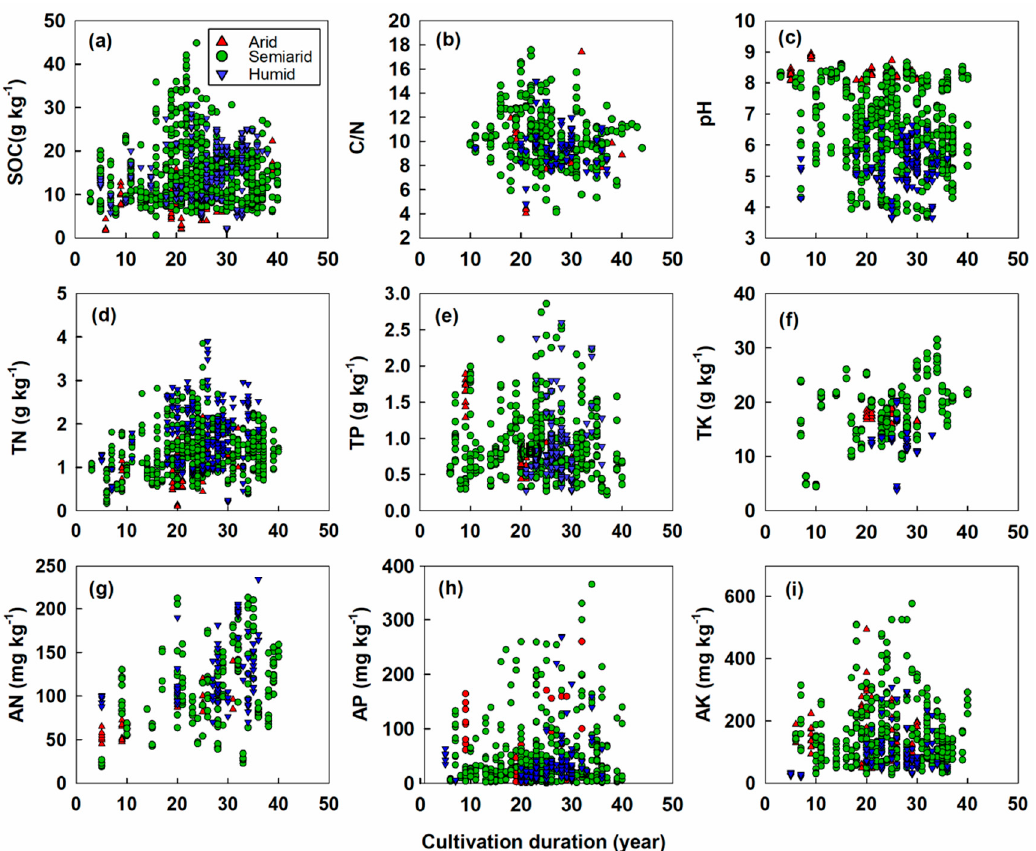
Figure 11. Effect of fertilizer on soil chemical properties. SOC ( a ): soil organic carbon, C/N ( b ): organic carbon − nitrogen ratio, pH ( c ), TN ( d ): total nitrogen, TP ( e ): total phosphorus, TK ( f ): total potassium, AN ( g ): alkali − hydrolysable nitrogen, AP ( h ): available phosphorus, AK ( i ): available potassium) with different HIs (humidity index) (HI = MAP/(MAT + 10)) (triangle: HI ≤ 25, circle: 25 < HI < 50, inverted triangle: HI ≥ 50). MAT: mean annual temperature, MAP: mean annual precipi- tation.